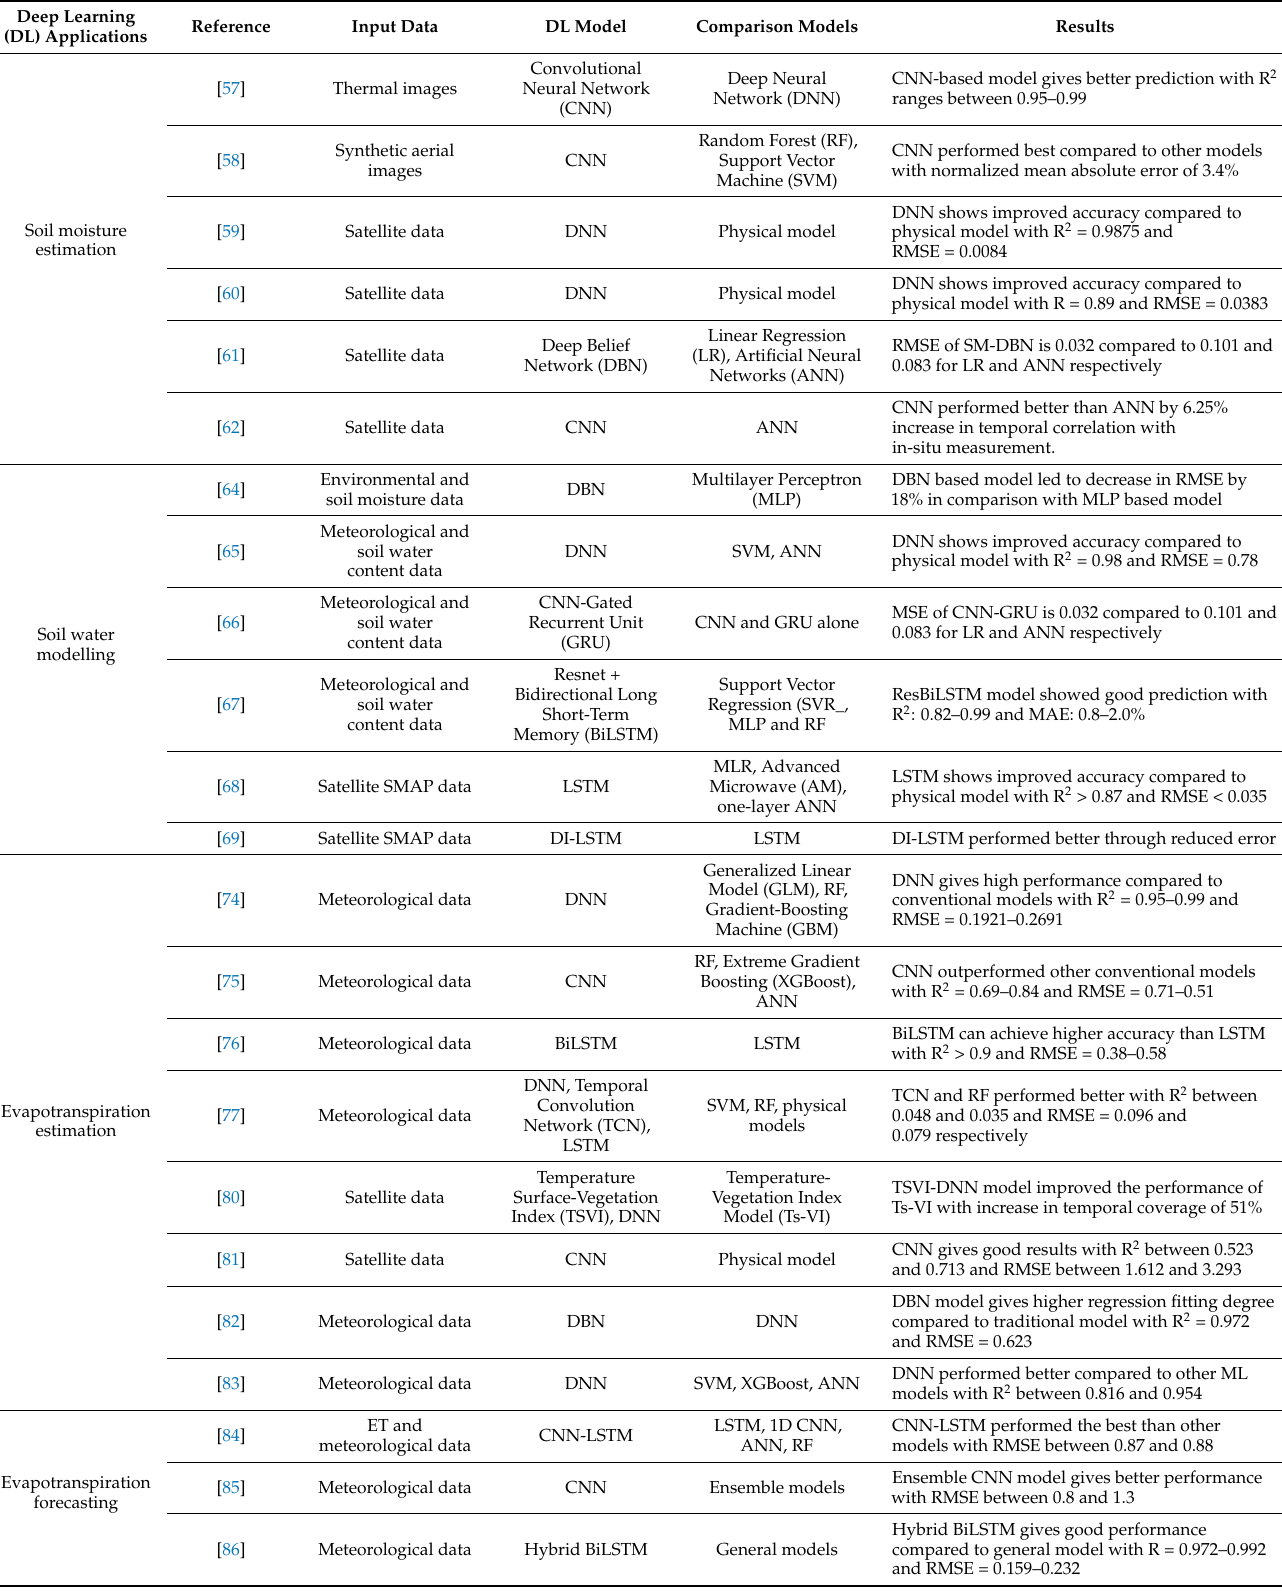
Table 1. Deep learning applications in plant water stress